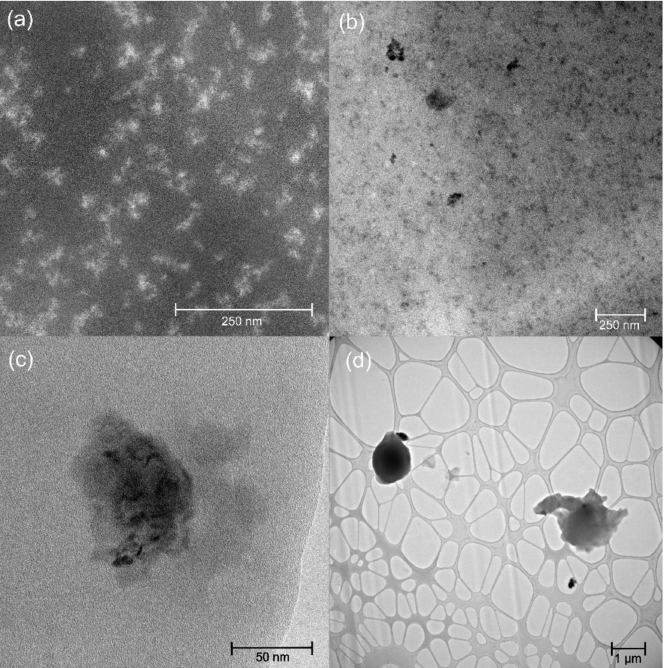
Figure 2. ( a ) Representative HAADF-STEM image of epoxy nanocomposite (5 wt.% SiO 2 ) prepared using pH 7 and APTES. ( b ) Representative TEM image of epoxy nanocomposite (5 wt.% SiO 2 ) prepared using pH 11 and APTES. ( c ) A single SiO 2 agglomerate consisting of smaller particles in